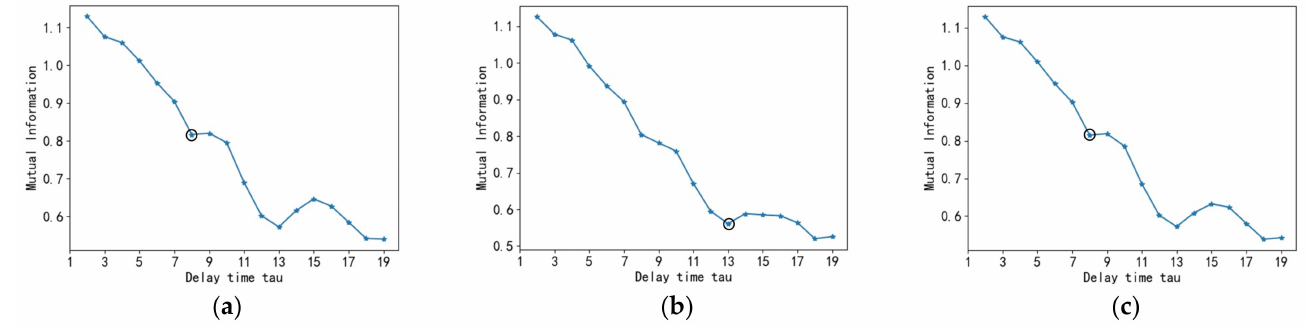
Figure 8. Mutual information function curve: ( a ) normal; ( b ) contains abnormal data; ( c ) after abnormal data